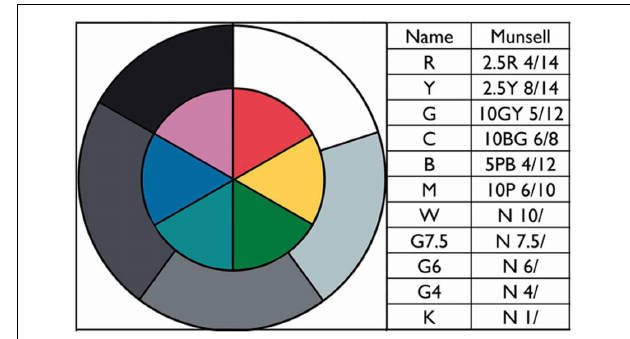
FIGURE 2 | “Ground truth” painted test target and the Munsell designations for the 11 paints. (1) Low Dynamic Range (LDR) with as uniform illumination as possible from multiple tungsten lights (diffused in an illumination cube).